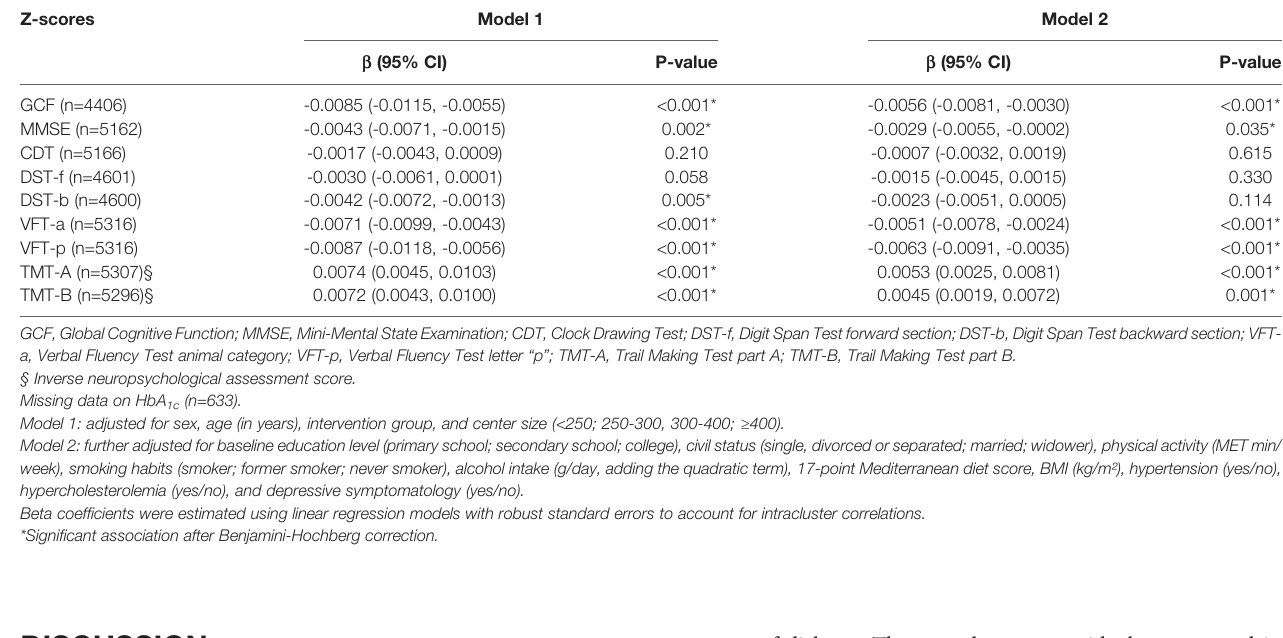
TABLE 4 | Association between baseline HbA 1c levels (per one mmol/mol increment) and cognitive Z-scores changes.